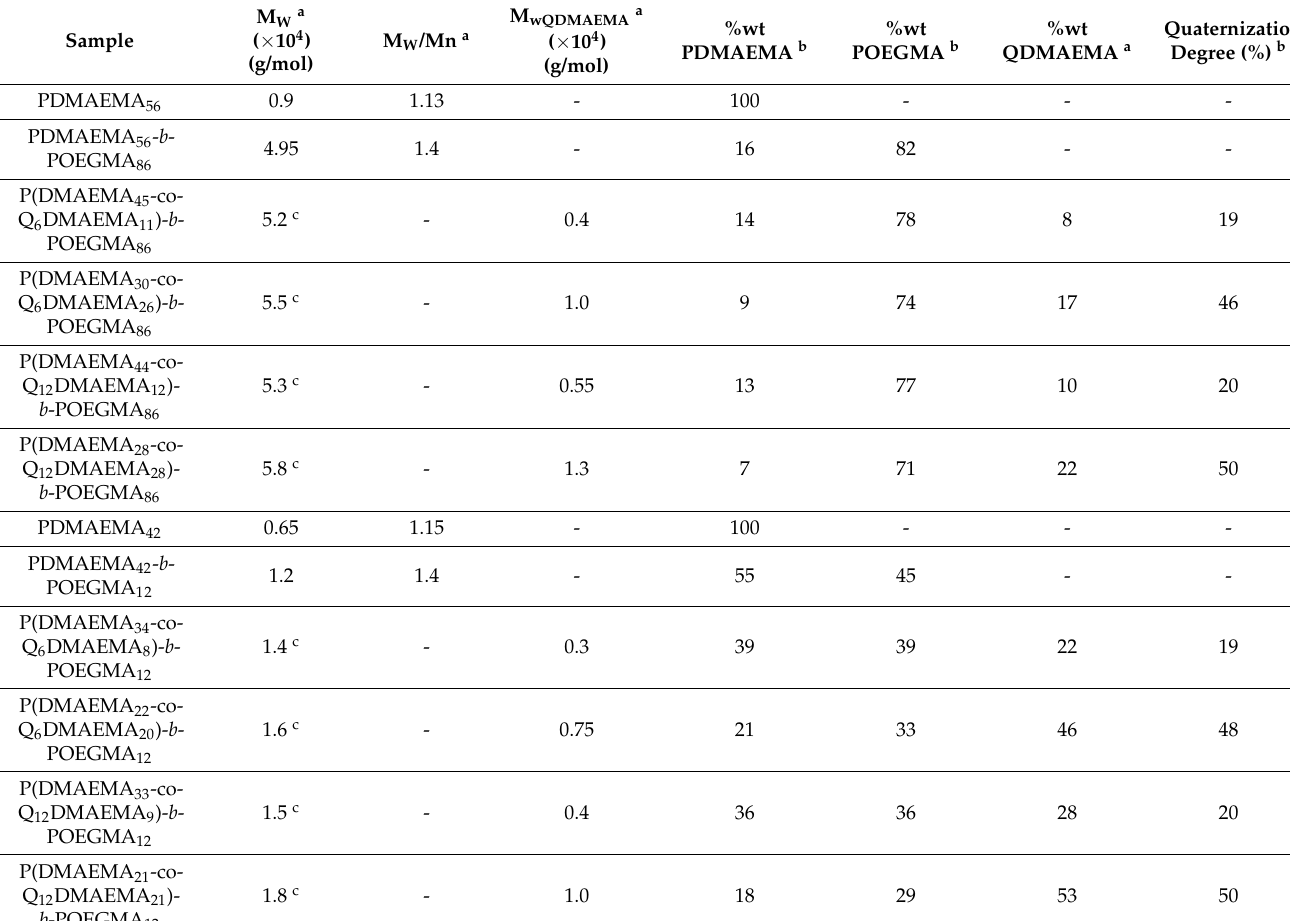
Table 1. Molecular characteristics of partially chemically modified P(DMAEMA-co-Q 6/12 DMAEMA)- b -POEGMA random diblock copolymers and their